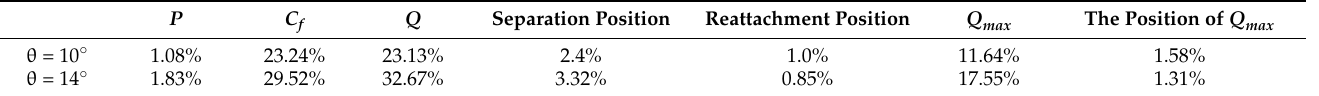
Table 4. Uncertainty values of the wall properties and important